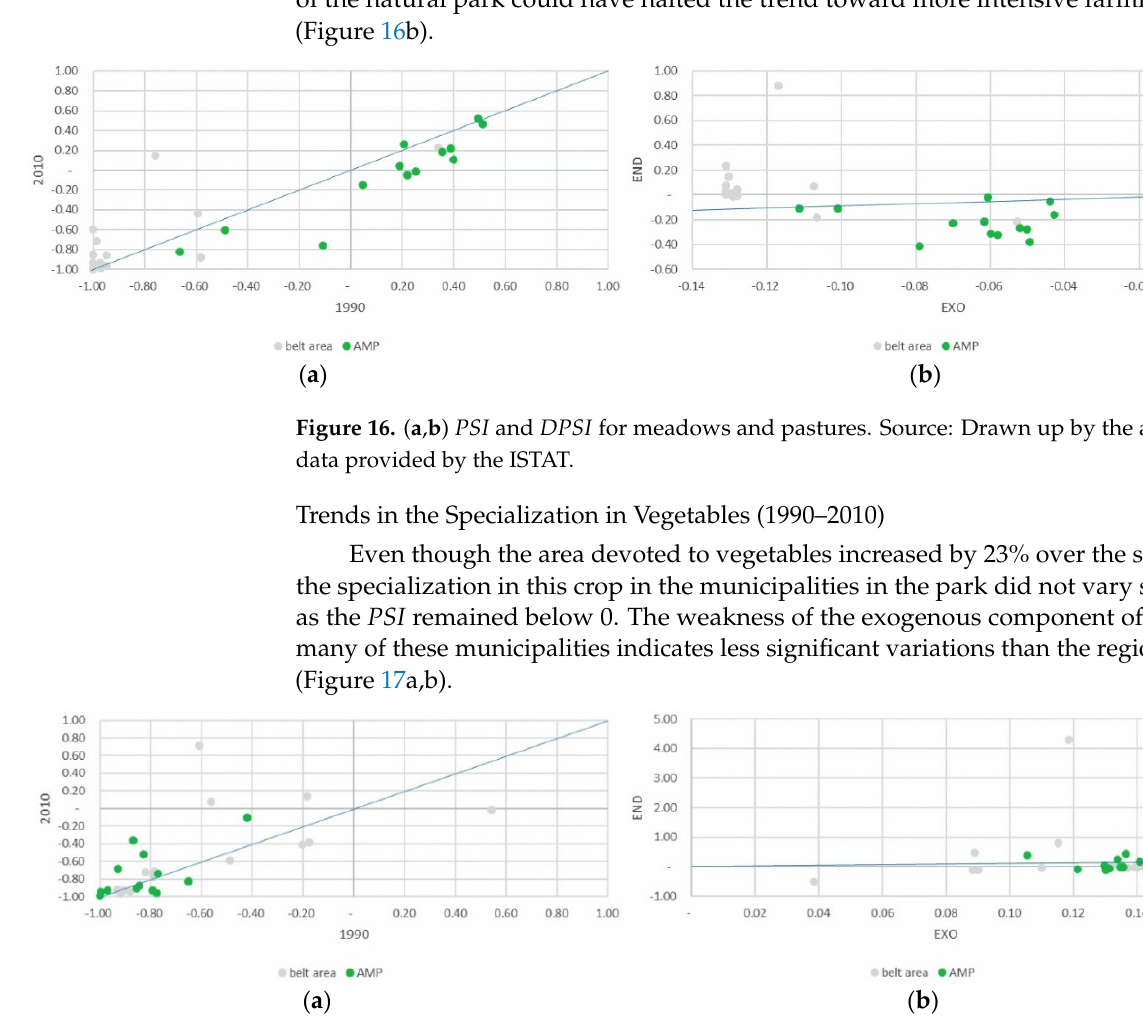
( b ) Figure 18. ( a , b ) PSI and DPSI of family vegetable gardens. Source: Drawn up by the authors using data provided by the ISTAT.